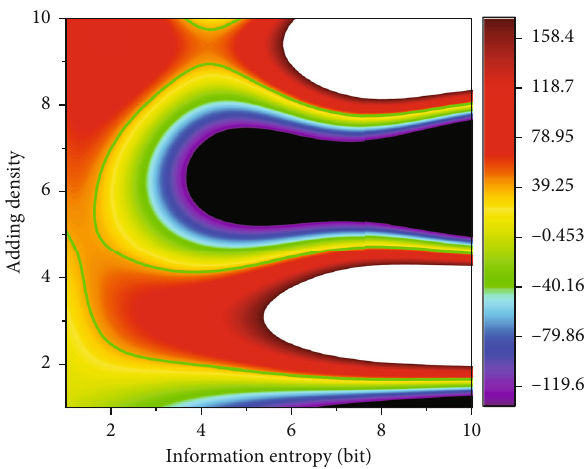
Figure 5: Phase point trajectory diagram for the hyperchaotic system.